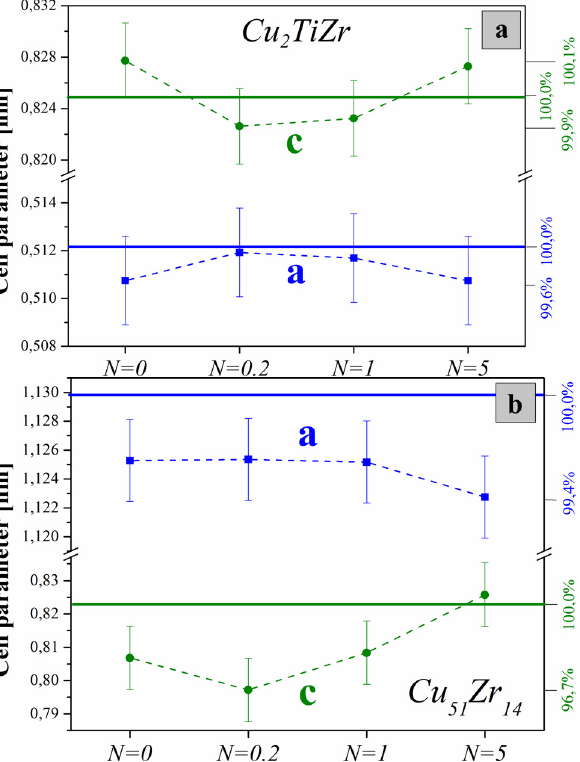
Figure 4: Calculated hexagonal cell parameters of the (a) Cu 2 ZrTi and (b) Cu 51 Zr 14 phases in the as-cast and deformed states. For comparison, the equilibrium cell parameters (horizontal lines) and the relative cell parameter variation are also indicated.